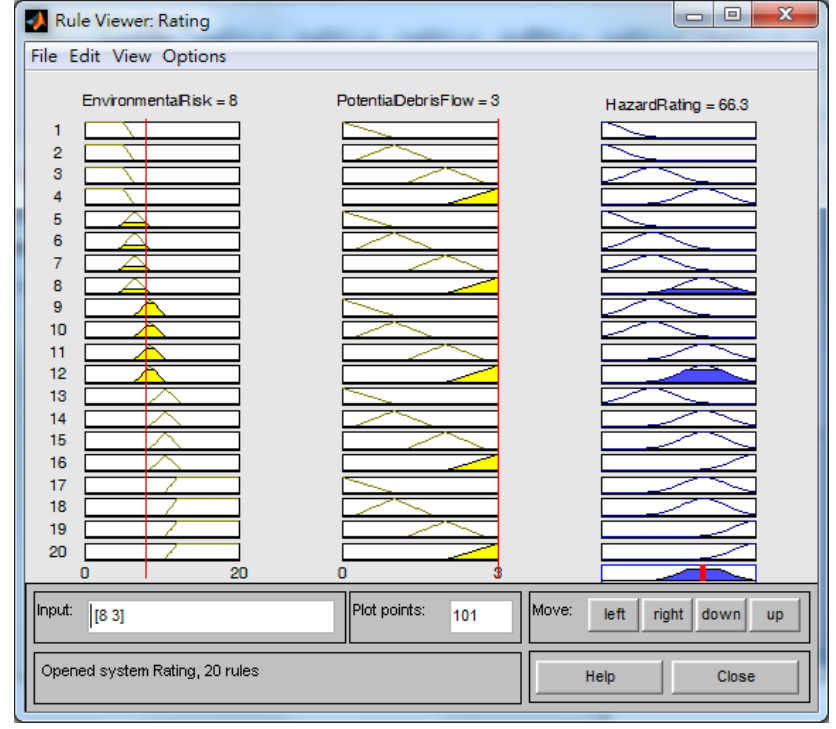
Figure 11. Hazard rating evaluated with fuzzy expert system (example for Dayuan Activity Center).